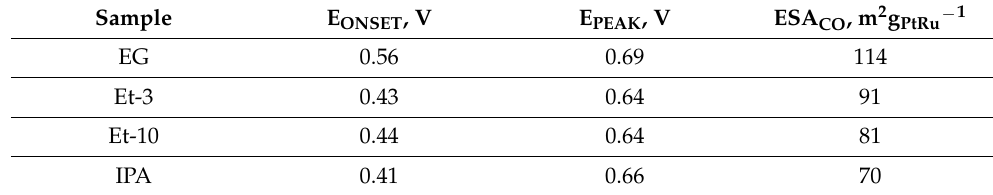
Figure 3. Voltammograms of the CO electrochemical desorption for the PtRu/C catalysts. The electrolyte is 0.1 M HClO 4 . The potential sweep rate is 40 mVs − 1 . Table 2. Electrochemical characterizations for the PtRu/C materials by CO-stripping voltammetry.